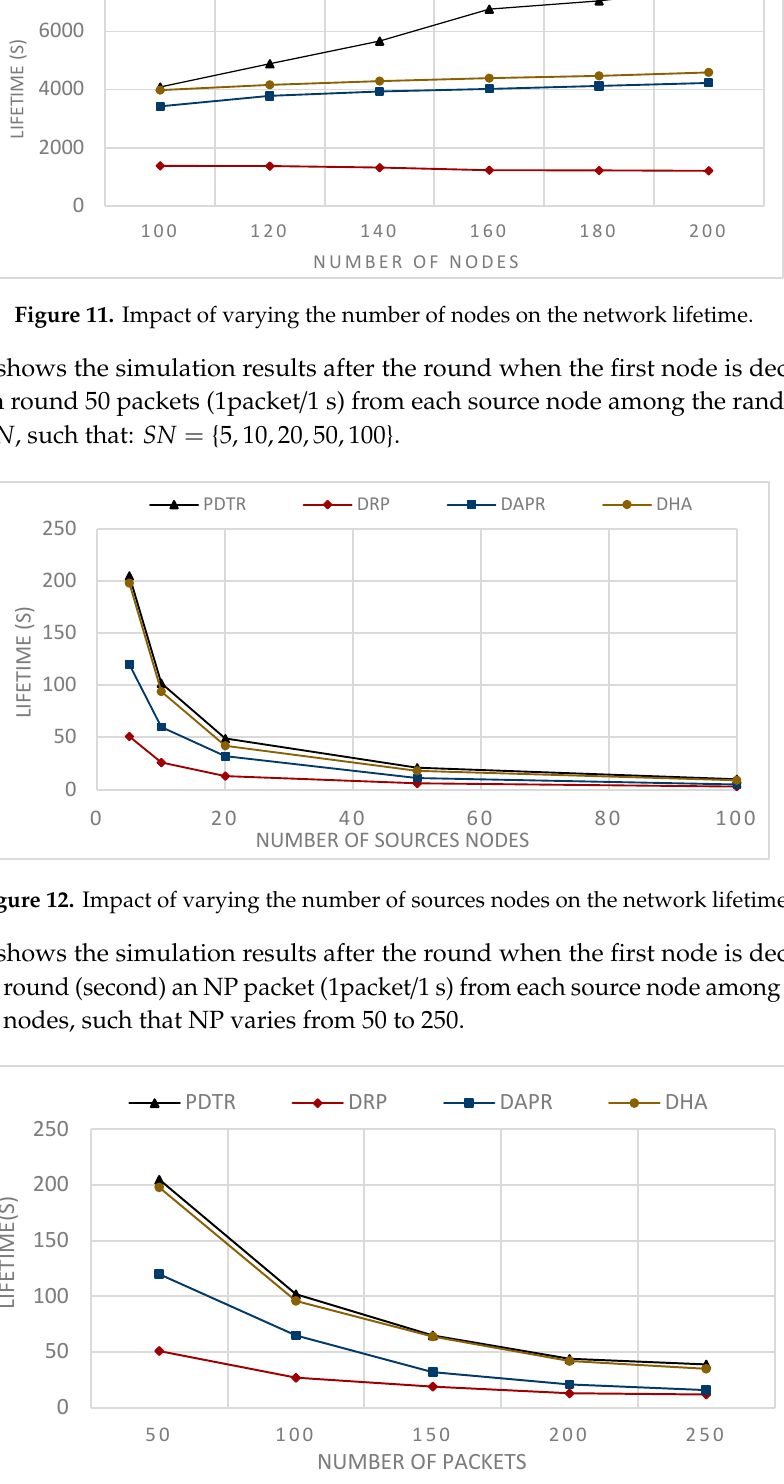
Figure 10. Impact of varying the communication range on the network lifetime.